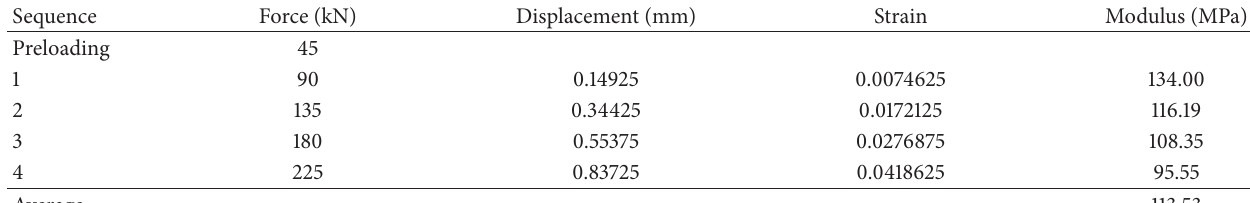
Table 1: Modulus test result of rubber